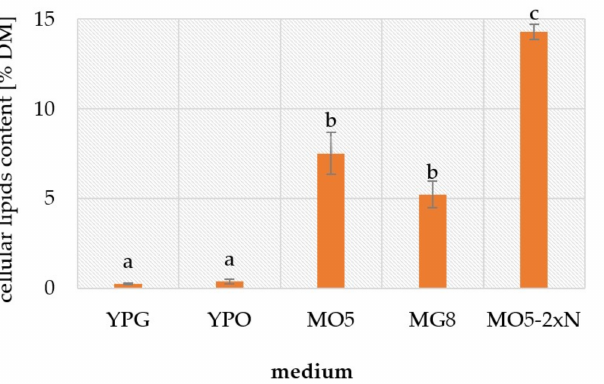
Figure 4. Cellular lipids content in yeast cells in the stationary phase in 84 h batch culture. The values with the same letter in a column did not differ significantly ( α = 0.05). The error bars indicate standard deviation.